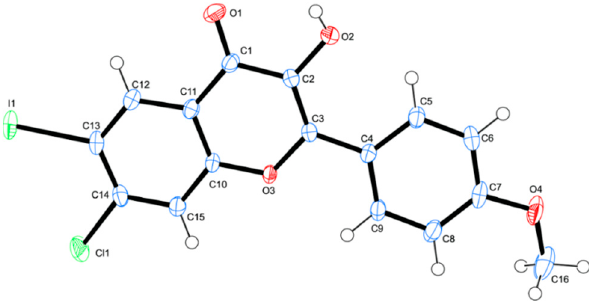
Figure 2. ORTEP diagram (50% probability level) of 3h .